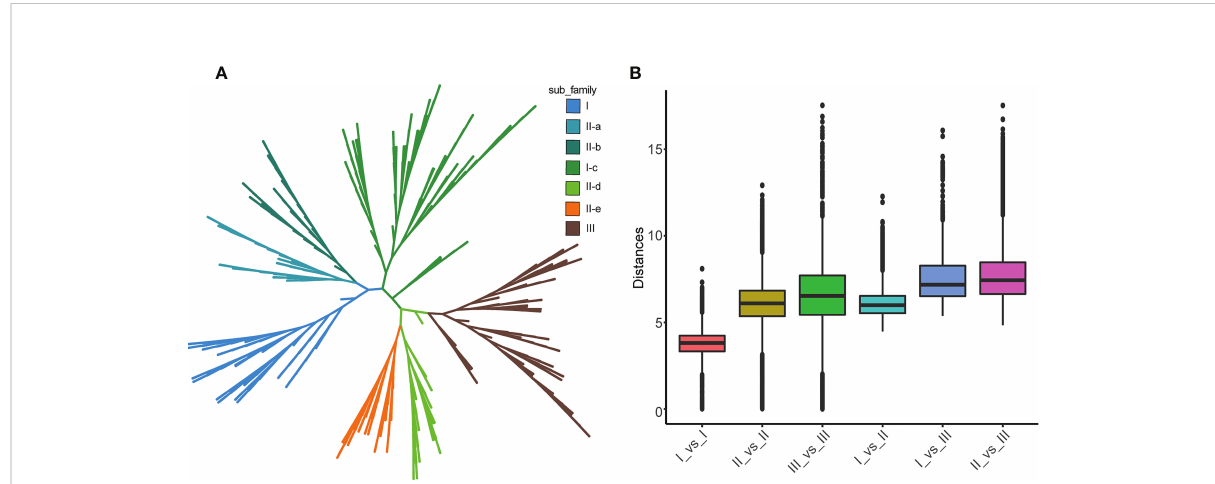
FIGURE 2 phylogenetic relationships and distance among the WRKY proteins from Tritipyrum and A thaliana. (A) Phylogenetic relationships among 414 WRKY proteins from Tritipyrum and A thaliana ; (B) genetic distance among the different clades of WRKY genes. The box plot shows the median (black line), interquartile range (box), and maximum and minimum scores (whiskers) of each data